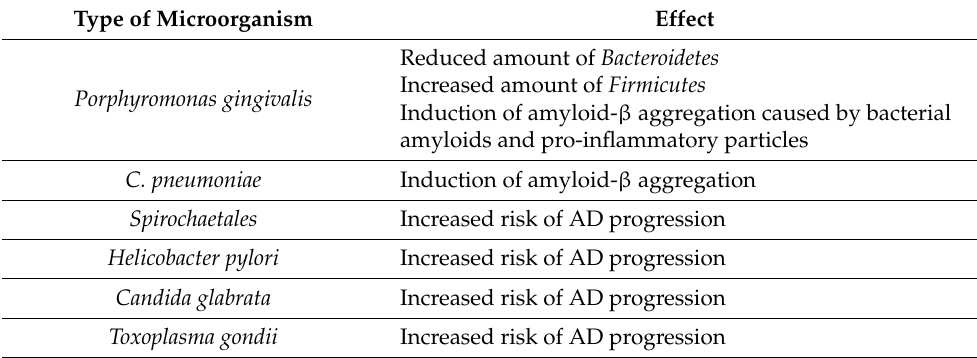
Table 1. Types of microorganisms causing the infection and their effects on the development of the